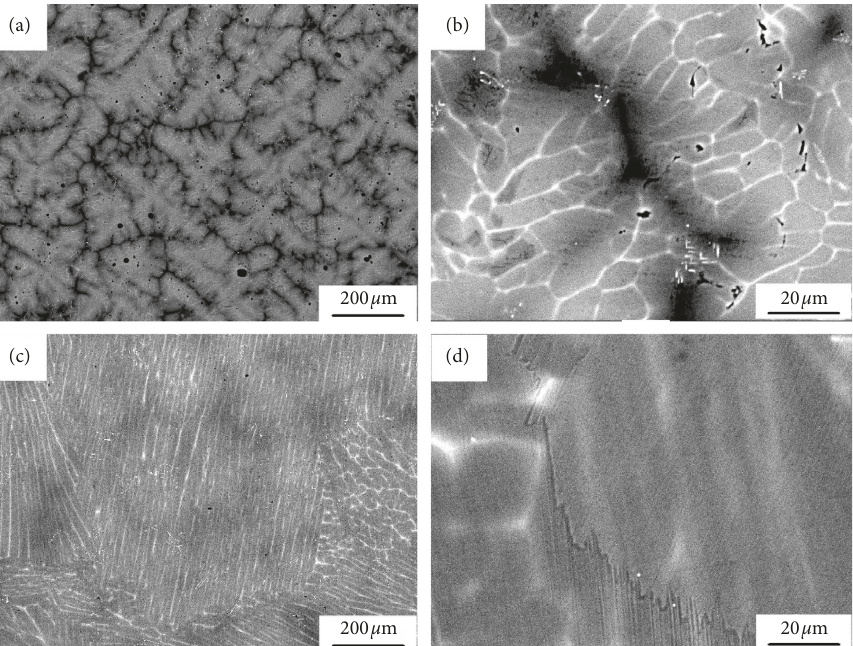
Figure 5: BSE images of transverse sections of the 200 μ m/s withdrawn DS ingot: (a, b) the mushy zone at low and high magnifications; (c, d) columnar zone 5mm below the mushy zone at low and high